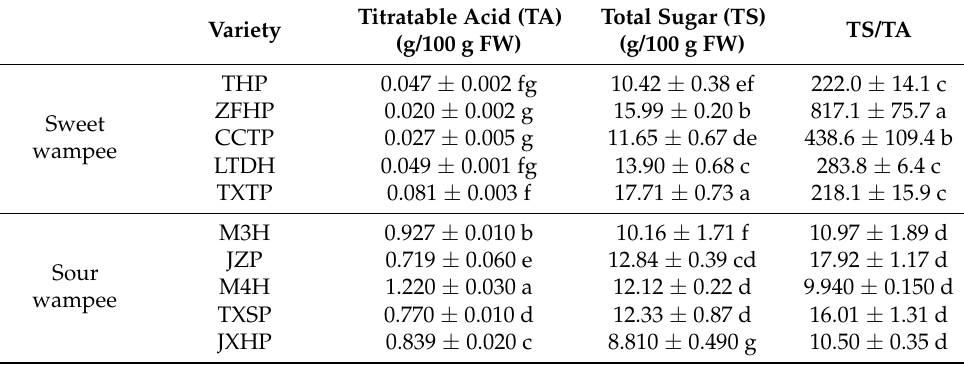
Table 1. Titratable acid and total sugar contents of sweet and sour wampee varieties.